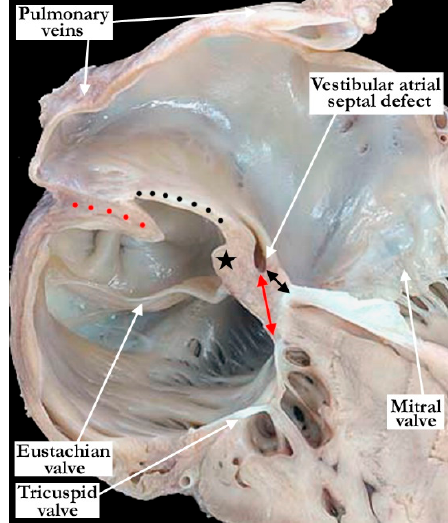
Figure 4. The heart is sectioned in a four-chamber plane to demonstrate the position of a vestibular atrial septal defect in the inferior muscular buttress. The defect occurs between the vestibules of the right and left atrium. When there is normal offsetting of the atrioventricular valves, as in the heart shown, the defect is typically closer to the mitral valve (double-headed black arrow) and farther from the tricuspid valve (double-headed red arrow). The antero-inferior rim of the oval fossa is marked with a black star. In this image, the opening of the defect to the right atrium is not seen. The flap valve (black dots) at the floor of the oval fossa was well-formed and overlaps the superior interatrial fold (red dots). Note the imperforate tricuspid valve in this heart which also had pulmonary atresia with an intact ventricular septum.